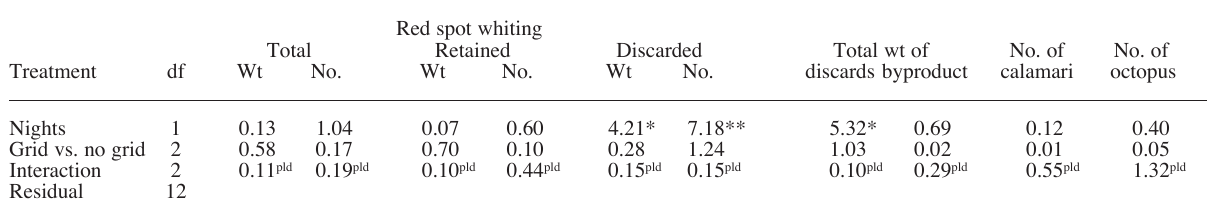
T ABLE 1. – Experiment 3: F ratios from two-factor analyses of variance to determine effects on catches due to fishing over 3 different nights with a 45 mm trawl body attached to a 41 mm square-mesh codend, with and without a grid in the extension section. All data were ln (x